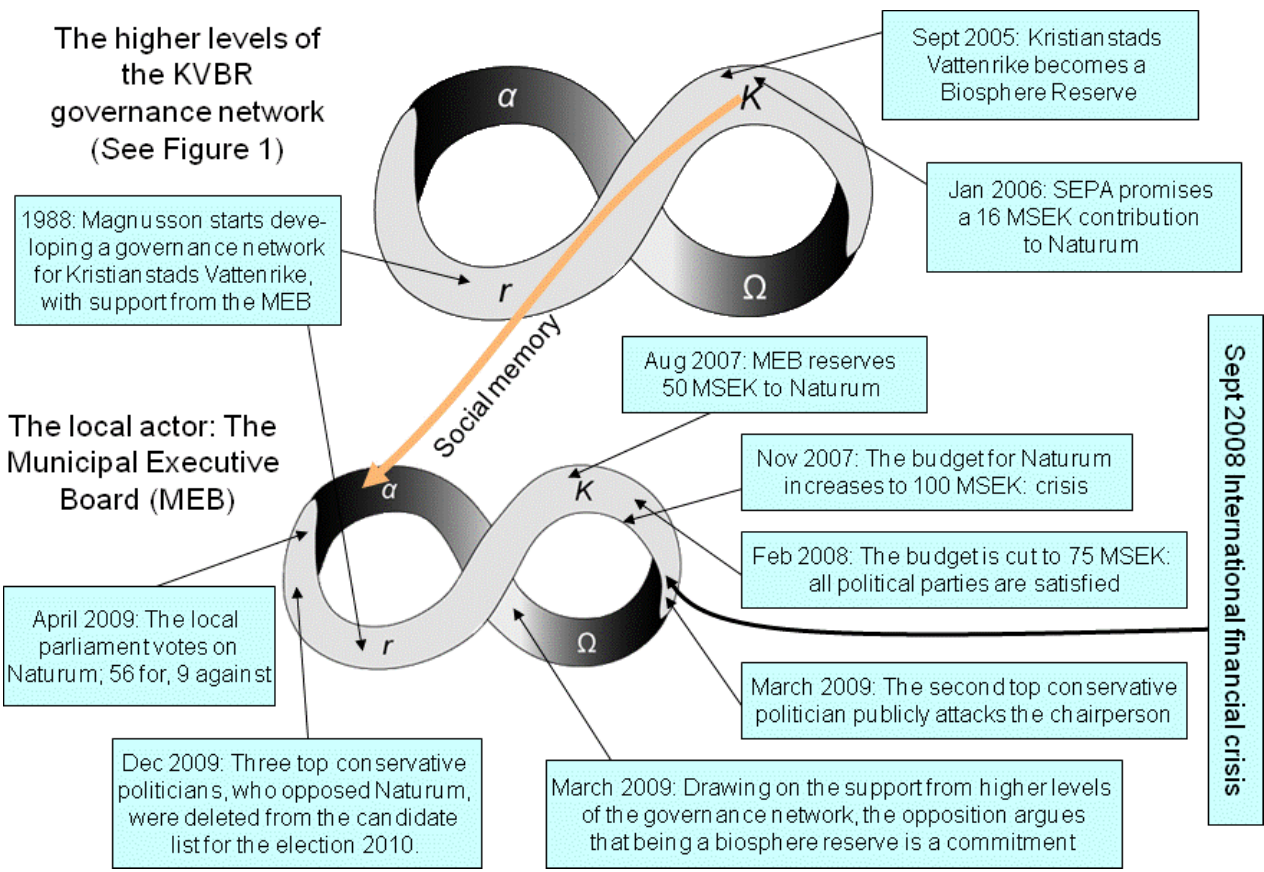
Fig. 2 . Two levels of the governance panarchy of KVBR concerning the dynamics around Naturum. The front loop, r to K , was driven in 1988–2006 by actors at both local and district/national levels. The MEB responded by making the appropriate decisions. In 2007–2009, two crises (internal project budget and externally imposed financial) pulled the biosphere development at the MEB level into the release ( W ) and renewal ( a ) phases (the back loop), whereas the governance network at higher levels remained in the conservation phase ( K ). The social memory at these higher levels—illustrated by the financial, intellectual, and moral–political support mainly from the SEPA, Unesco MAB, the CAB, and Region Scania—influenced the MEB to continue developing the biosphere reserve. The ruling conservative party reorganized